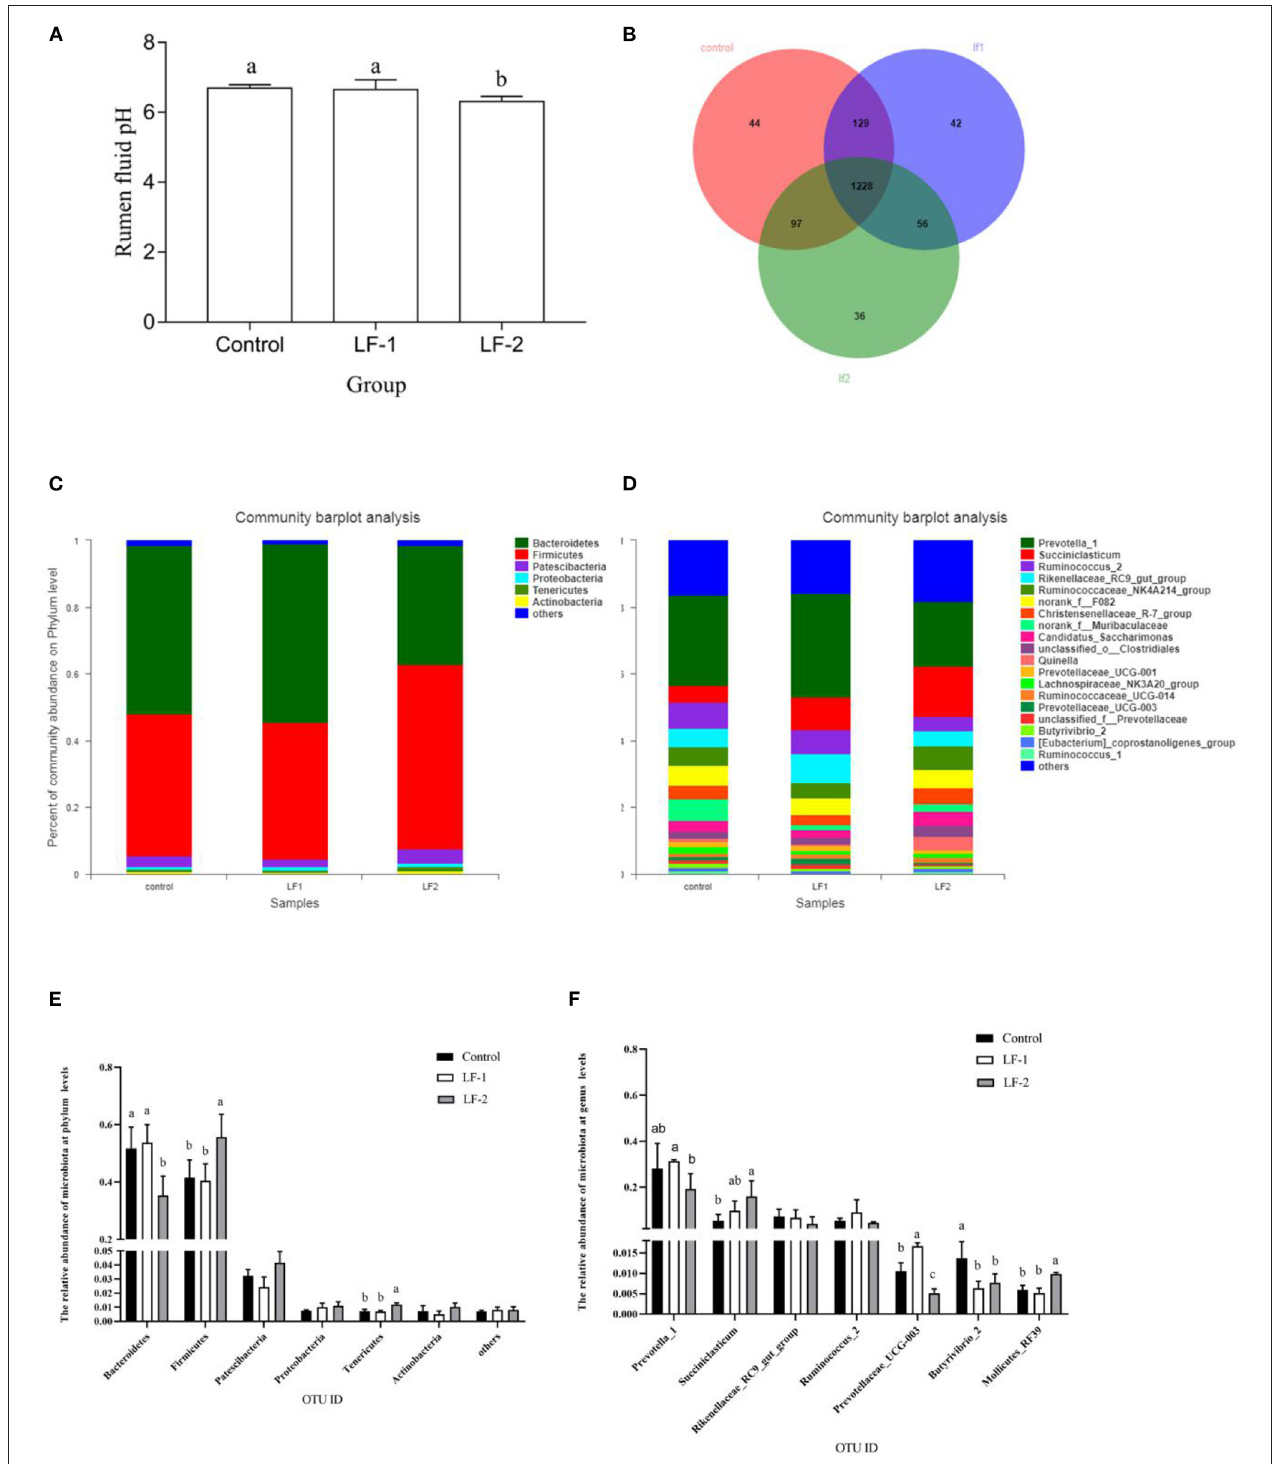
FIGURE 1 | The effect of supplementation of BLFc at the rate of 100 mg/kg/day (LF-1) or 200 mg/kg/day (LF-2) on (A) rumen pH, (B) number of operational taxonomic unit (OTU), (C) rumen microbial diversity at the phylum level, (D) rumen microbial diversity at the genus level in dairy goats, (E) effects of BLFc on the relative abundance of rumen microbiota at phylum levels in goats, and (F) effects of BLFc on the relative abundance of rumen microbiota at genus levels in goats. In (A) , (E) , and (F) : abc Treatment means with different letter differ ( p < 0.05).